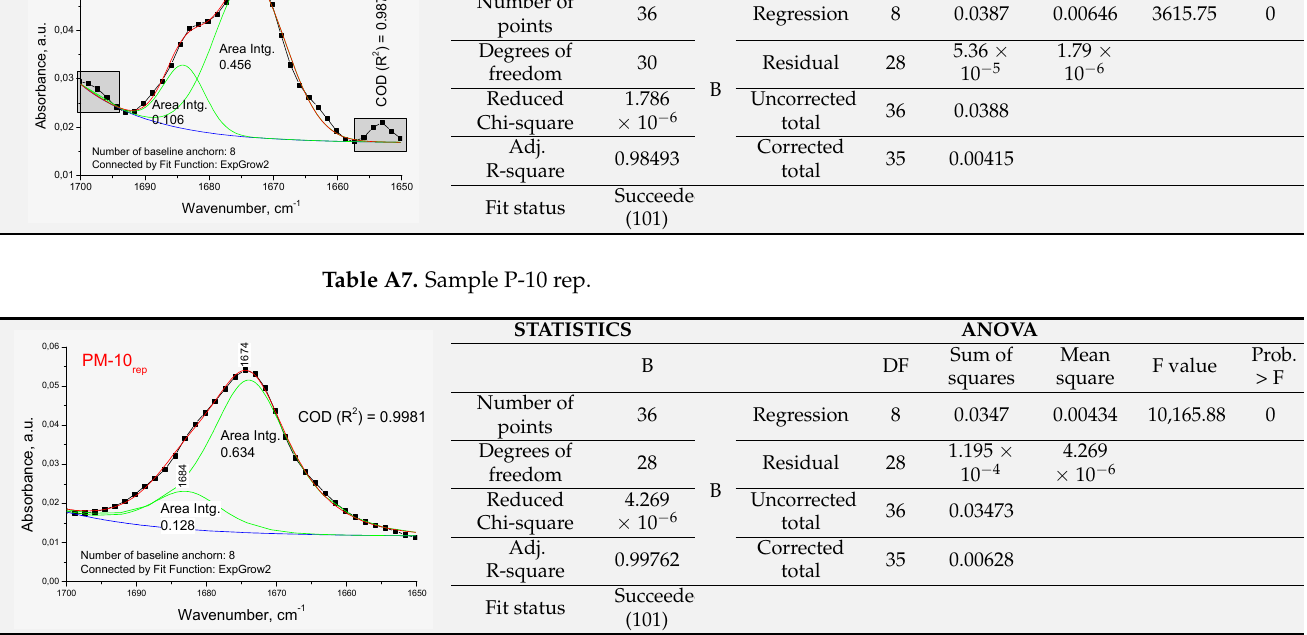
Sum of Mean Prob. > DF F value squares square F